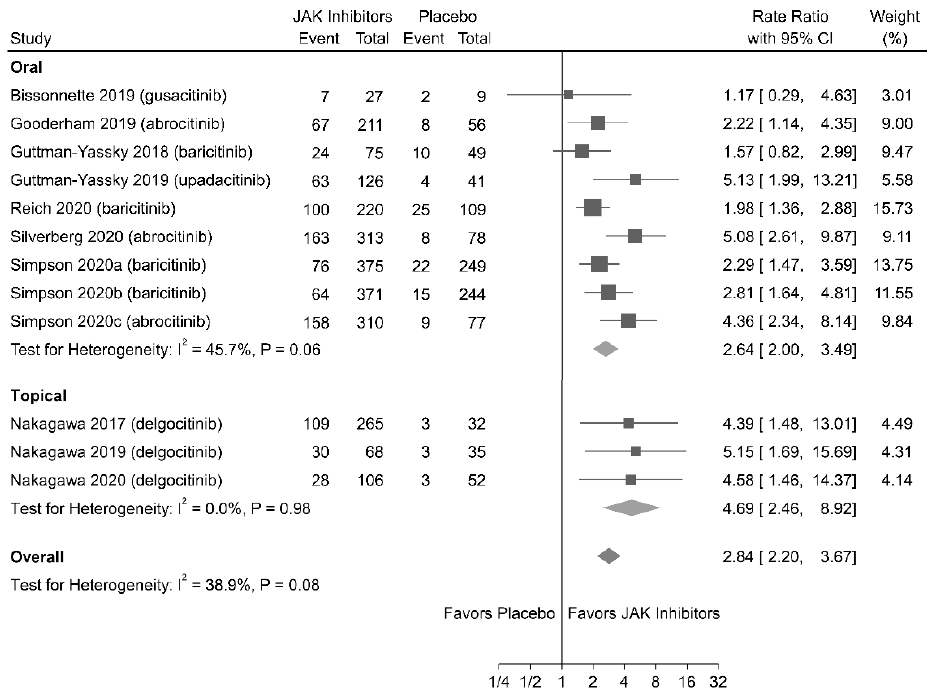
Figure 1. Association of Janus kinase (JAK) inhibitors versus placebo achieving at least a 75% improvement in Eczema Area and Severity Index (EASI) score from the baseline (EASI-75 response). CI, confidence interval.